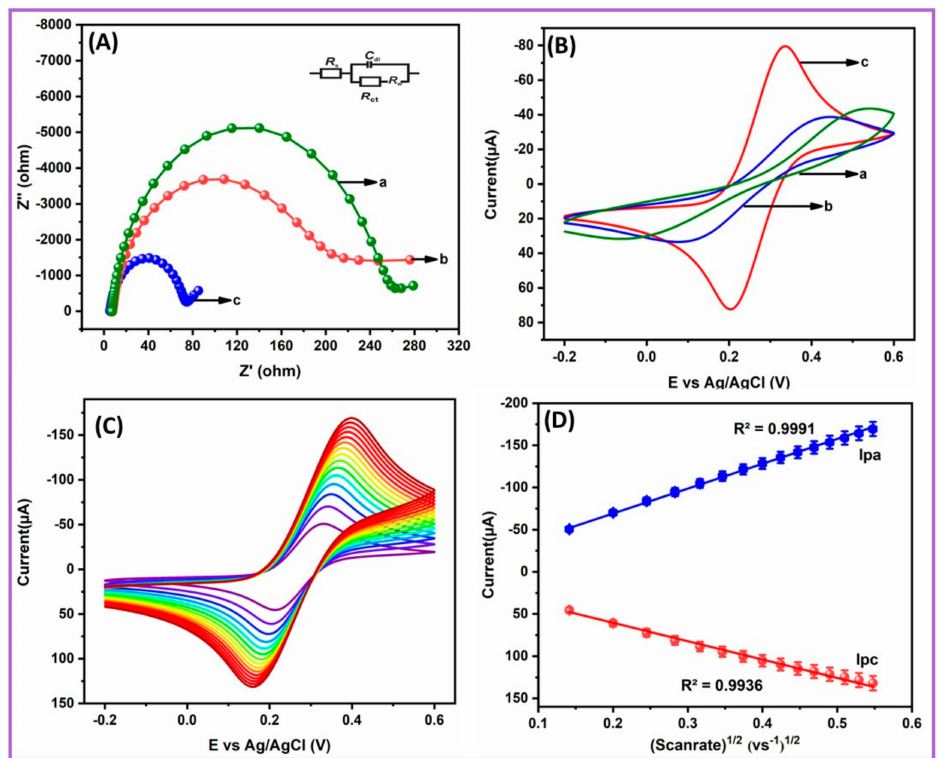
Figure 4. ( A ) EIS and ( B ) cyclic voltammetry (CV’s) ( a ) of unmodified electrode, ( b ) NiCo 2 O 4 -MFs / GCE and (c) NiCo 2 S 4 -Ms / GCE in 0.1-M KCl containing 0.05 M of [Fe(CN) 6 ] − 3 / − 4 . ( C ) Scan rate of the nanocomposite modified electrode. ( D ) Calibration plot of ( v vs. Vs − 1 ) 1 / 2